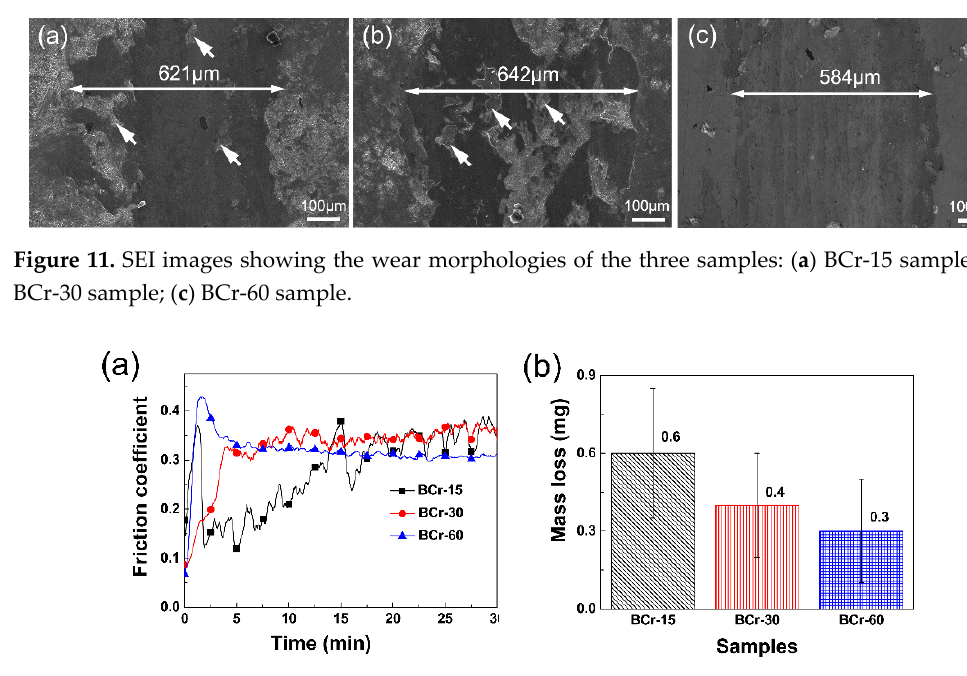
Figure 12. Friction coefficient plotted as a function of sliding friction time for different samples ( a ) and Mass loss ( b